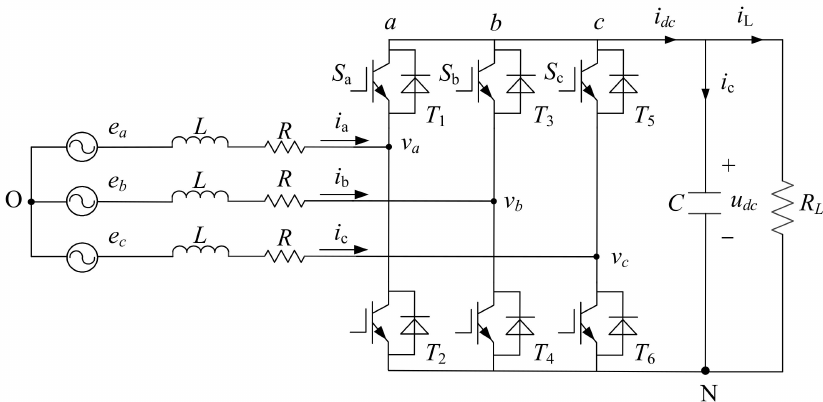
Figure 1. Three-phase PWM